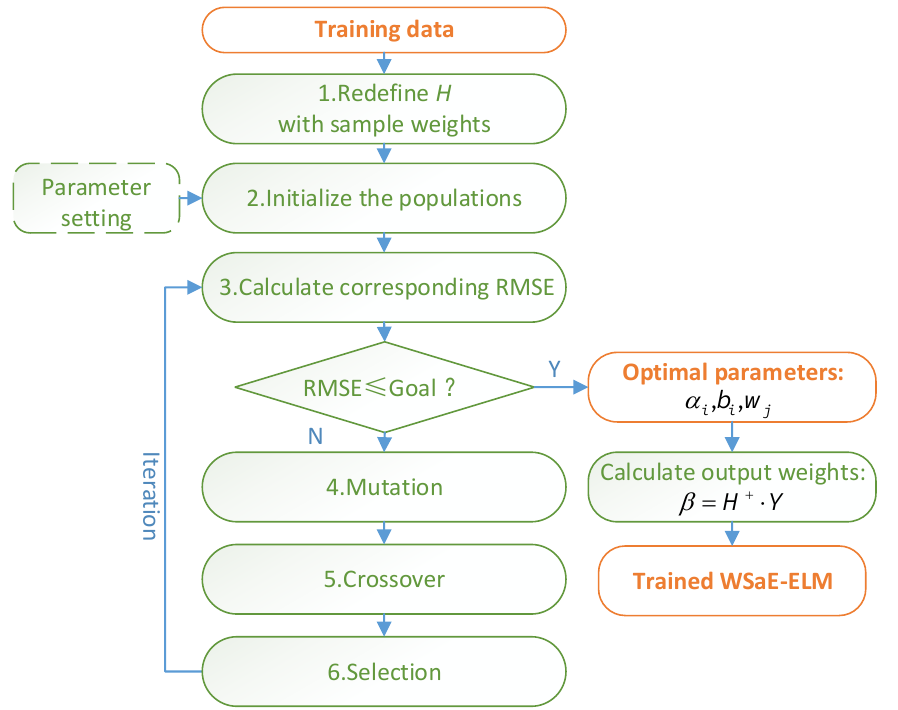
Figure 3. The procedure of weighted self-adaptive evolutionary extreme learning machine (WSaE-ELM).